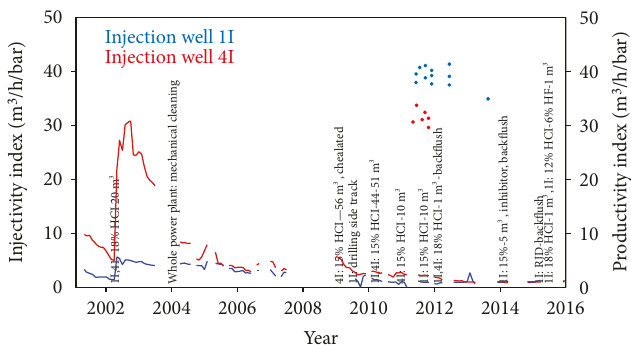
Figure 2: Injectivity and productivity indices of two injection wells including stimulation treatments between 2001 and 2016. Lines show daily measurements of injectivity index; dots show single production tests in well 1I (blue) and well 4I